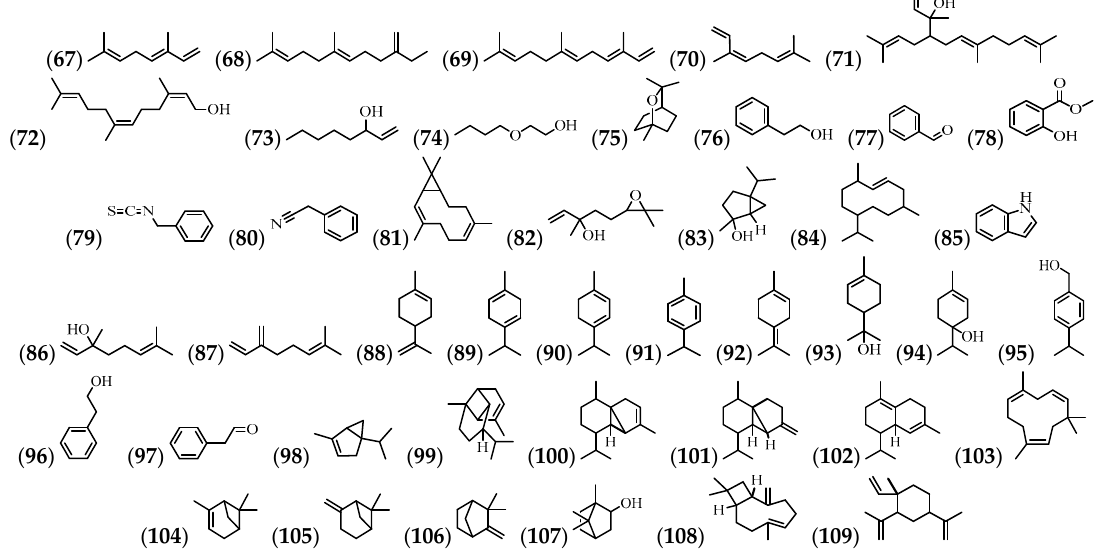
Figure 5. The structures of the volatile compounds from A. cathartica.